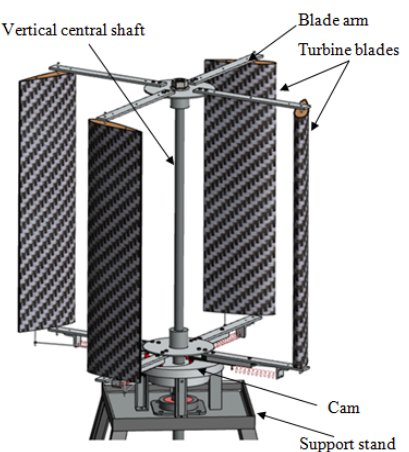
Figure 3. Graphical representation of blade pitching method